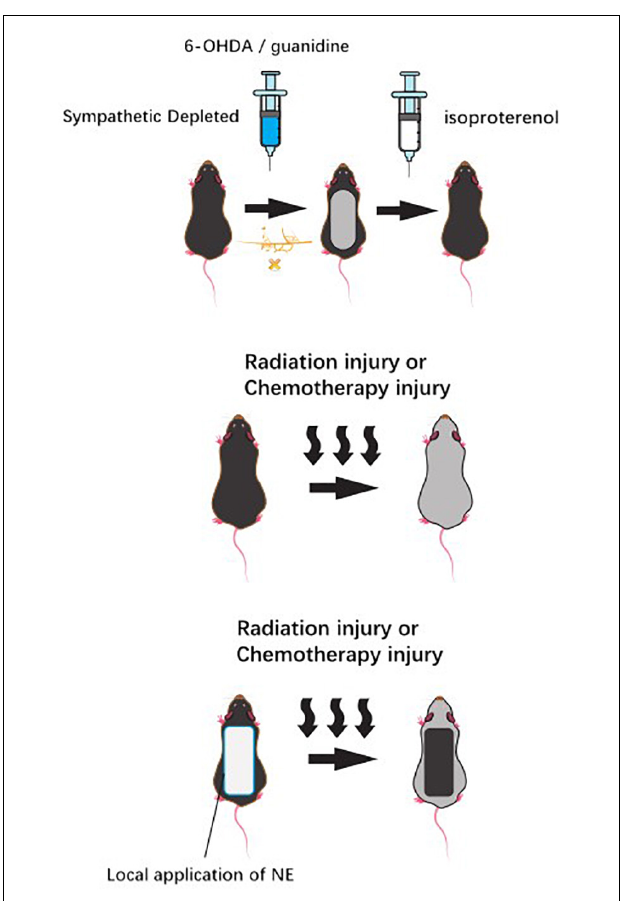
FIGURE 3 | Chemical sympathetic nerve depletion via administration of the neurotoxin 6-hydroxydopamine (6-OHDA) or guanidine to mice inhibited HF growth, while usage of isoproterenol recovered the hair growth. Likely, topical application of norepinephrine to the back skin of rats before a large radiation insult or large systemic chemotherapy insult can prevent the alopecia that was seen in vehicle control animals.